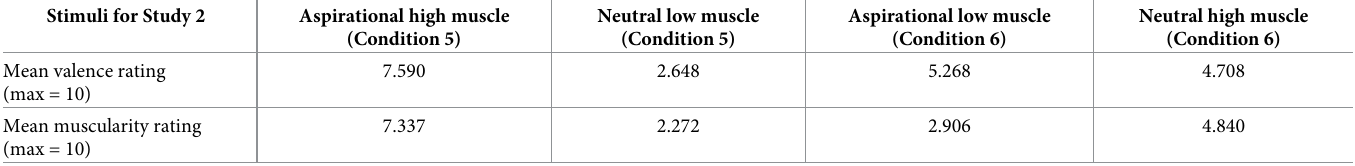
Table 4. Results from the pre-rating task: Mean ratings for valence and muscularity for each of the 24 selected images across each of the 4 stimuli categories. Stimuli for Study